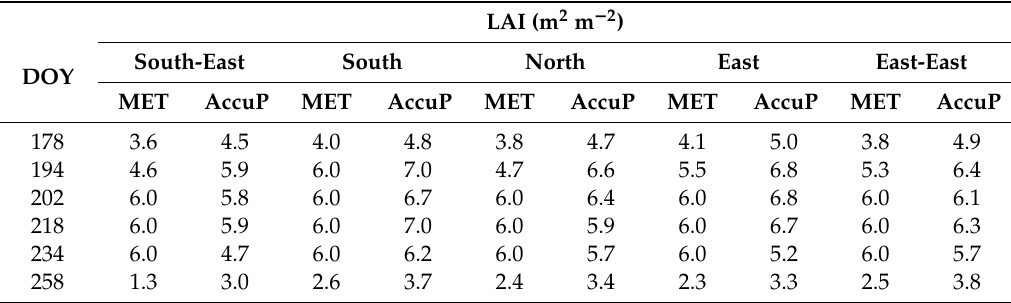
Table 3. Comparison of LAI values estimated with the METRIC (MET) model and measured with AccuPAR (Accup) at five locations during the 2016 growing season, for assessing the LAI by the METRIC model.